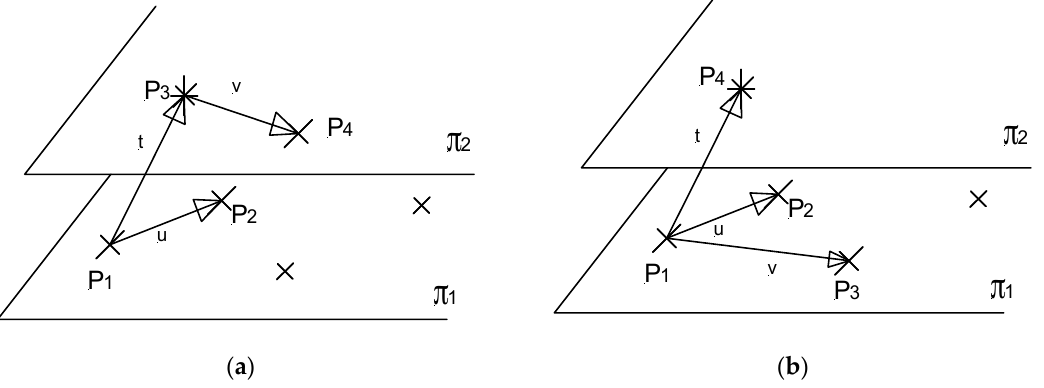
Figure 3. Flatness under minimum zone tolerance criteria. ( a ) configuration (2–2); ( b ) configuration (3–1).